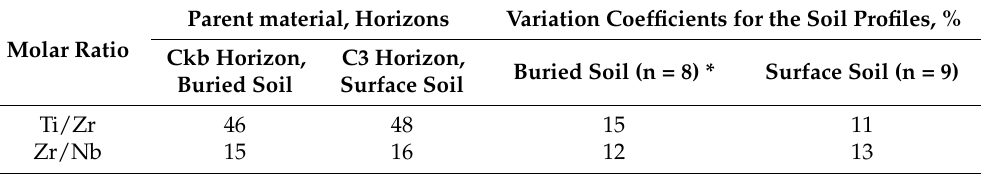
Table 5. Molar ratios of immobile elements in the buried and the surface soils.